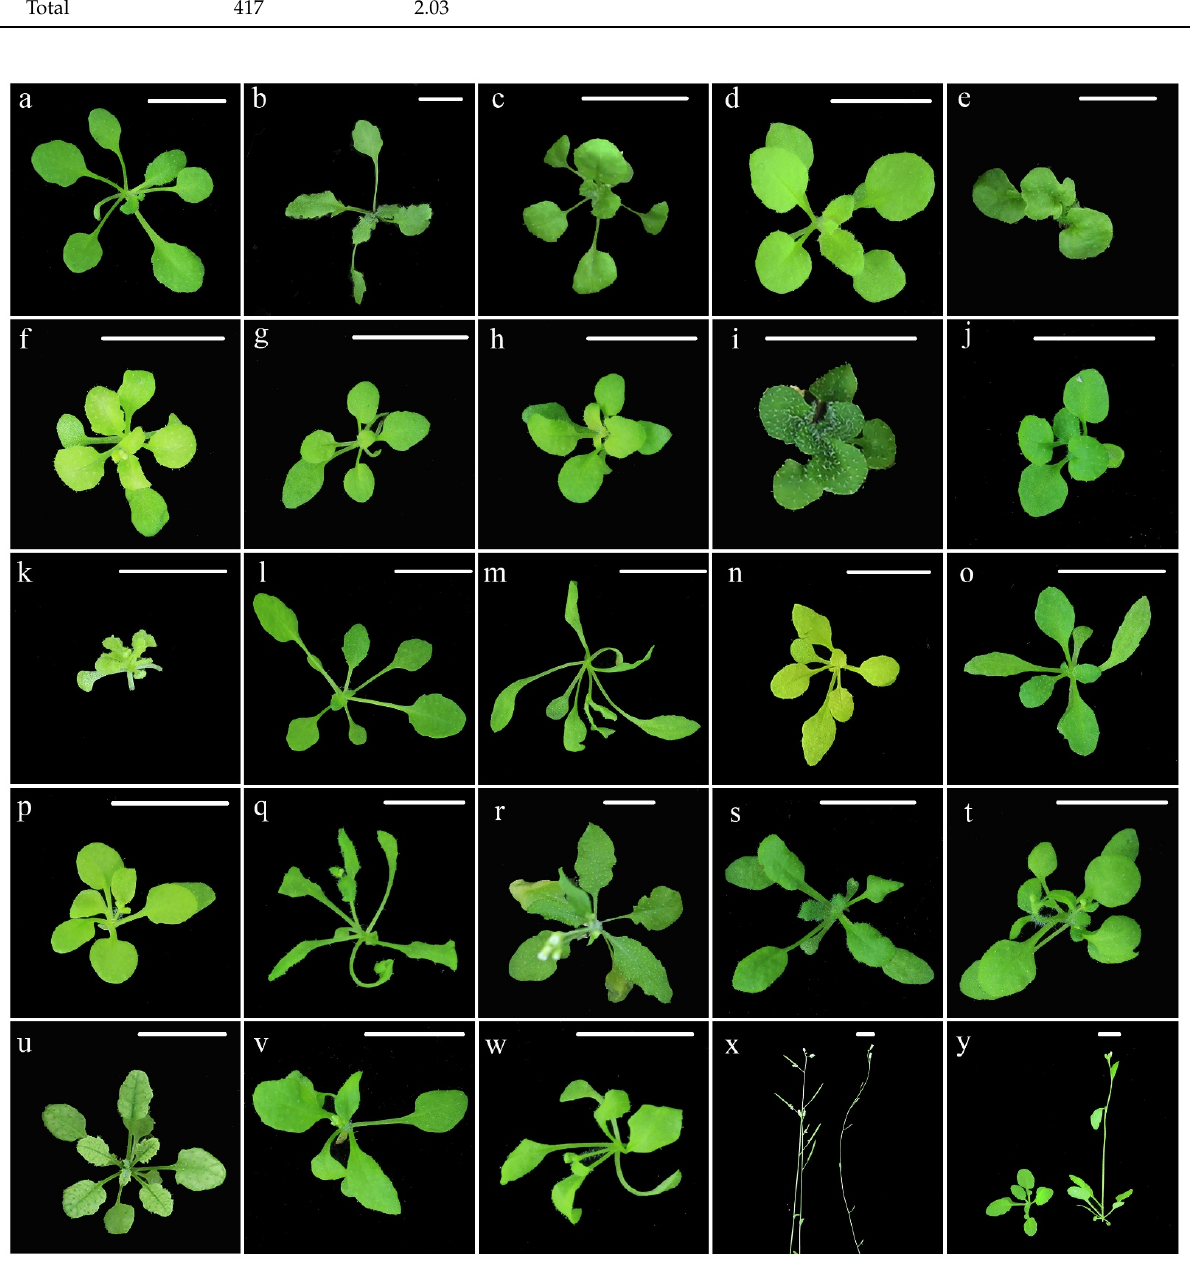
Figure 2. Phenotype of partial mutants induced by gamma ray irradiation. ( a ), Wild type; ( b – y ), mutants. For ( x , y ), the left plant is WT, the right plant is the mutants. Scale bars, 10 mm. Table 1. Classification of visible mutation phenotype induced by gamma rays in M 2 generation.